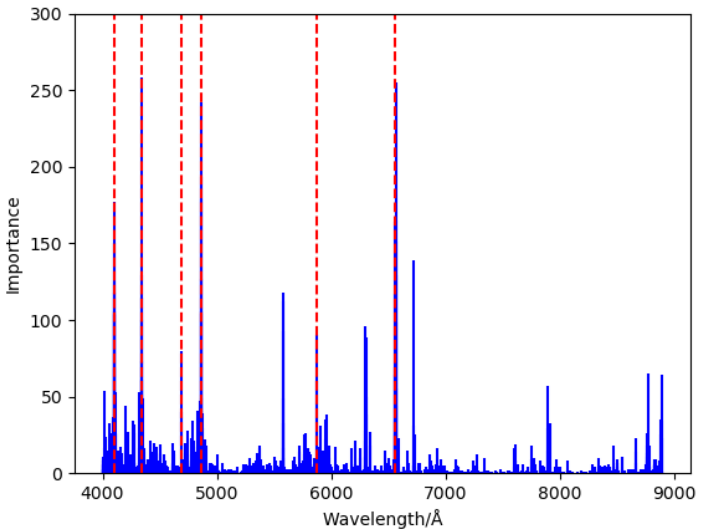
Figure 4. Importance of features. The blue solid lines represent the importance of each wavelength; the red dotted lines represent the wavelengths of the Balmer lines and He lines.